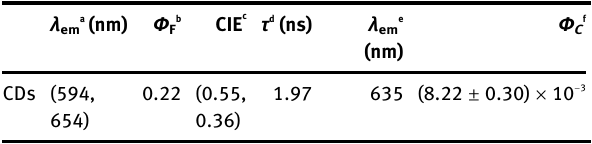
Table  : Photophysical characteristics of the CDs.